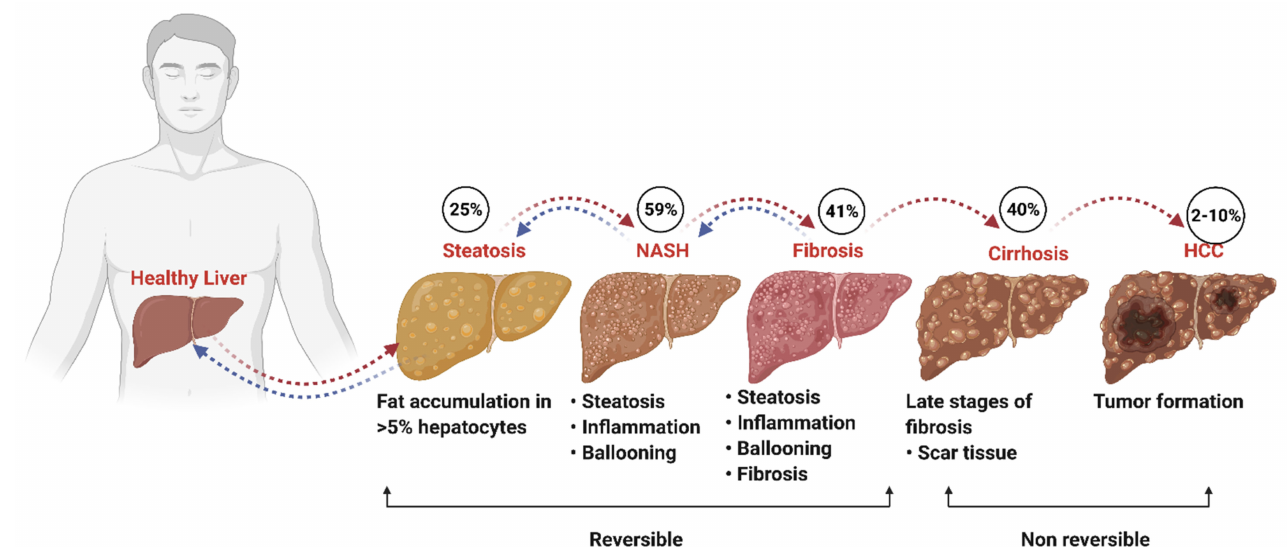
Figure 1. Progression of NAFLD. Simple steatosis is the initial phase of NAFLD characterized by excessive accumulation of fat in the hepatocyte. With time, steatosis progresses to a more inflammatory state called NASH in approximately 59% of patients. In addition, 41% of patients can develop more severe conditions such as fibrosis and cirrhosis (40%), leading to hepatocellular carcinoma in 2–10% [1]. Steatosis, NASH, and fibrosis are reversible with timely and appropriate interventions, while later stages cannot be reversed. (Created with